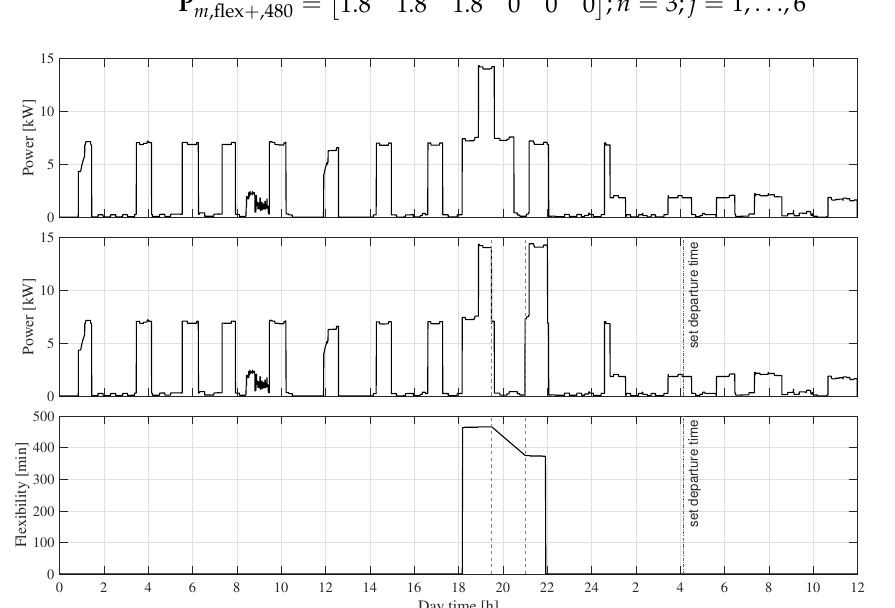
Figure 11. Consumption profile for the use-case scenario without ( top ) and with flexibility event ( middle ) offering the EV flexibility with the calculated duration flexibility and end-user set departure time ( bottom ). The chosen flexibility event is marked by a red-dotted area.